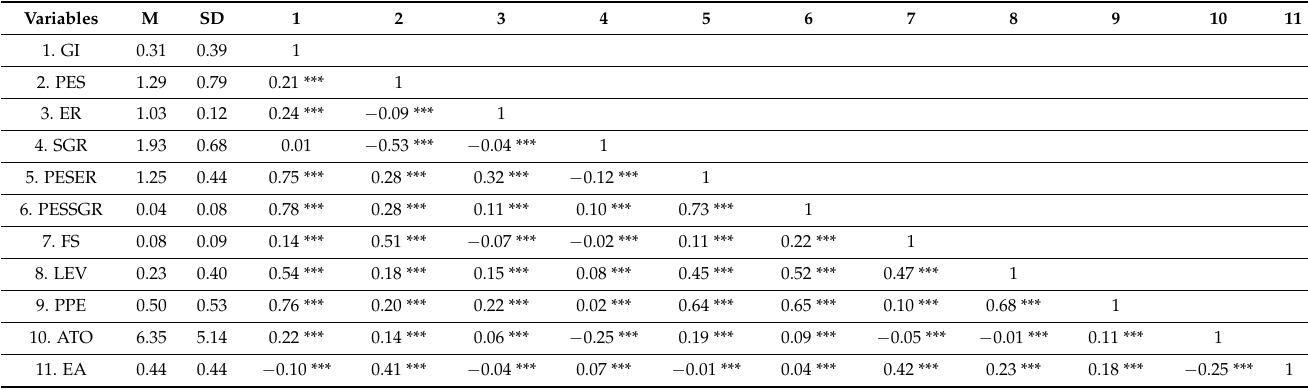
Table 2. Descriptive statistics and